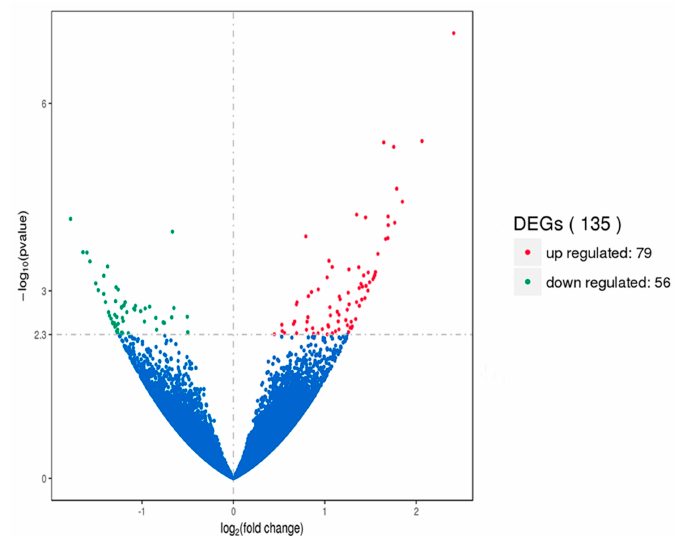
Figure 1. Volcano plot of differentially expressed genes in the hypothalamus. DEGs were filtered using a p- value < 0.005 as a threshold. Red spots represent up-regulated genes, and green spots indicate down-regulated genes. Blue spots represent genes that did not show obvious changes between the HEP and LEP samples.